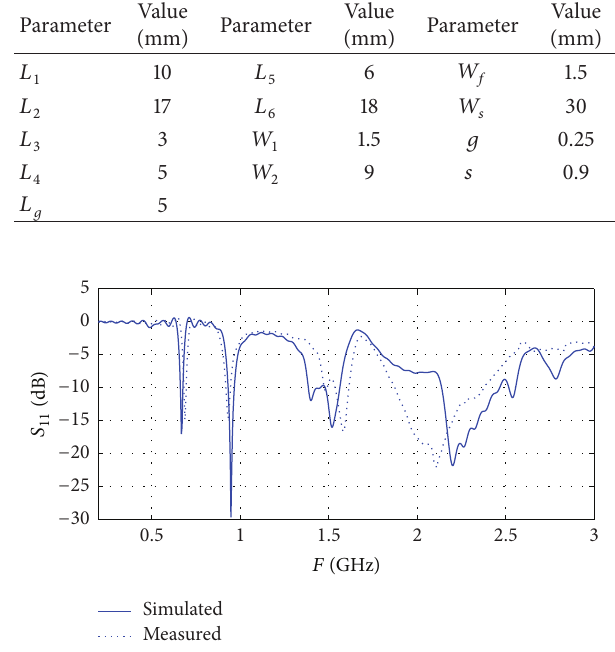
Figure 3: Measured and simulated reflection coefficient of the proposed antenna.